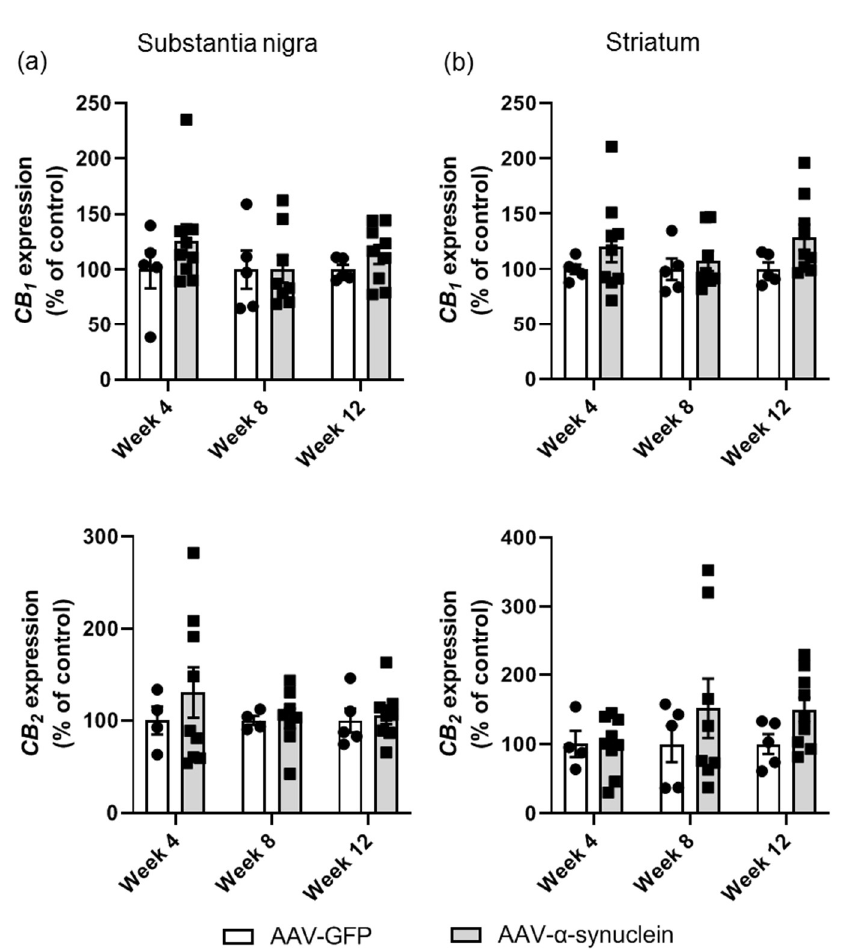
Figure 5. qRT-PCR analyses of cannabinoid receptor expression in the nigrostriatal pathway. There was no effect of AAV-α-synuclein expression on CB 1 or CB 2 gene expression in ( a ) the substantia nigra or ( b ) the striatum. Data are represented as mean ± SEM with 4–9 animals per group by two-way ANOVA.